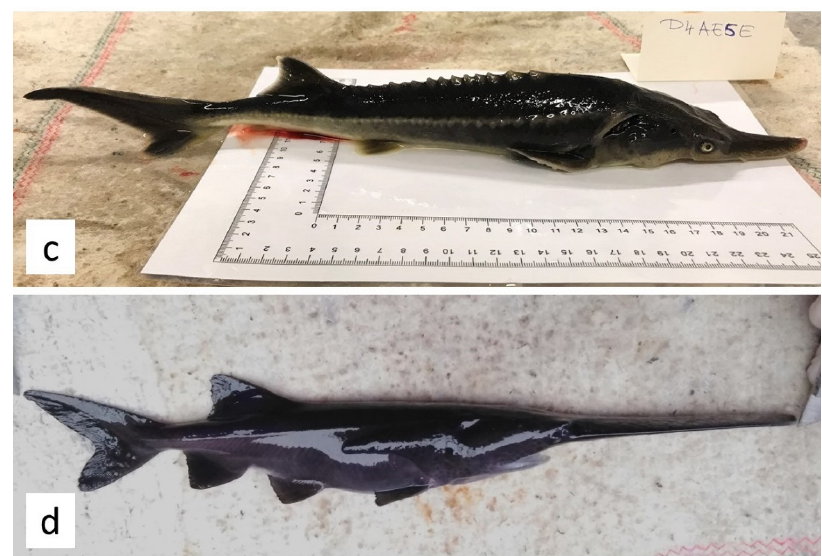
Figure 4. ( a ) Yearlings of A. gueldenstaedtii and ( b ) their hybrids: ( c ) typical LH hybrid, ( d ) typical SH hybrid of P. spathula .